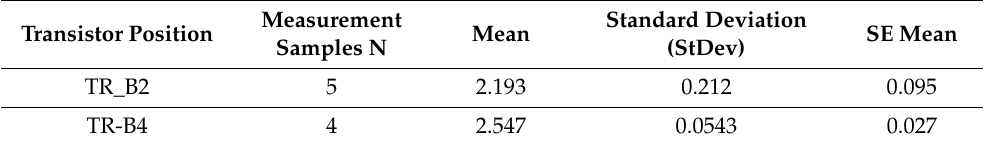
Table 3. T-test results of two groups of R thaverage values determined for two transistor positions TR_B2 and TR_B4.